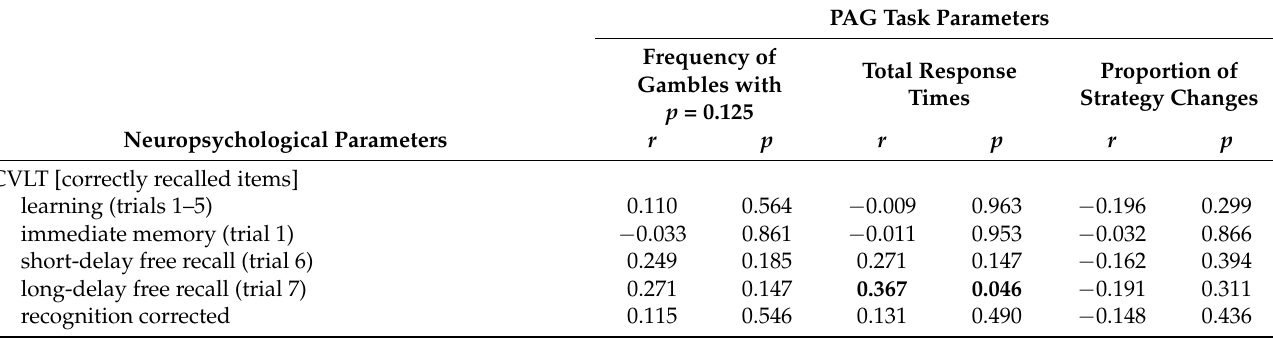
Table 6. Pearson’s correlations between decision making performance and neuropsychological background scores in healthy controls (n =